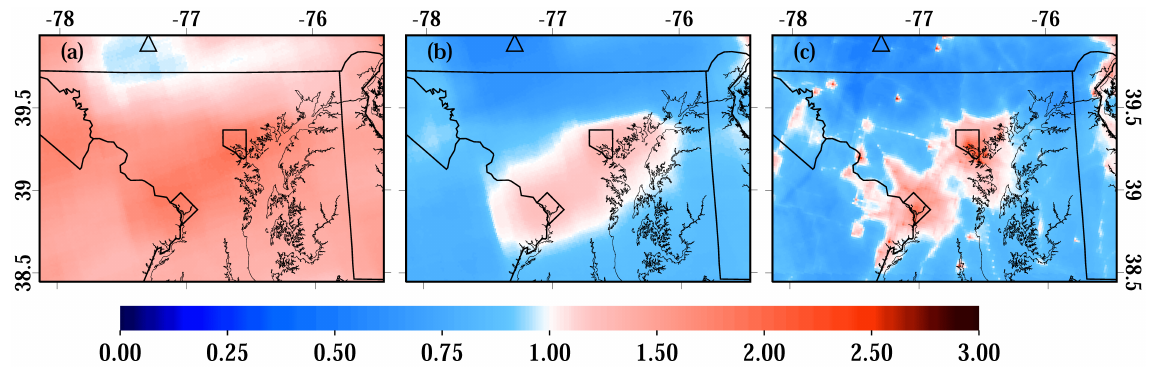
Figure 5. Ratio between the three OMI_CMAQ tropospheric NO 2 retrievals and the operational NASA v3.0 OMI tropospheric NO 2 re- trieval for June and July 2008–2012 (2 months × 5 years; 10 months total). (a) OMI_CMAQ/OMI_GMI. (b) OMI_CMAQ_O/OMI_GMI. (c) OMI_CMAQ_OD/OMI_GMI. In all plots, Arendtsville, PA, is denoted by the triangle in the top left corner.